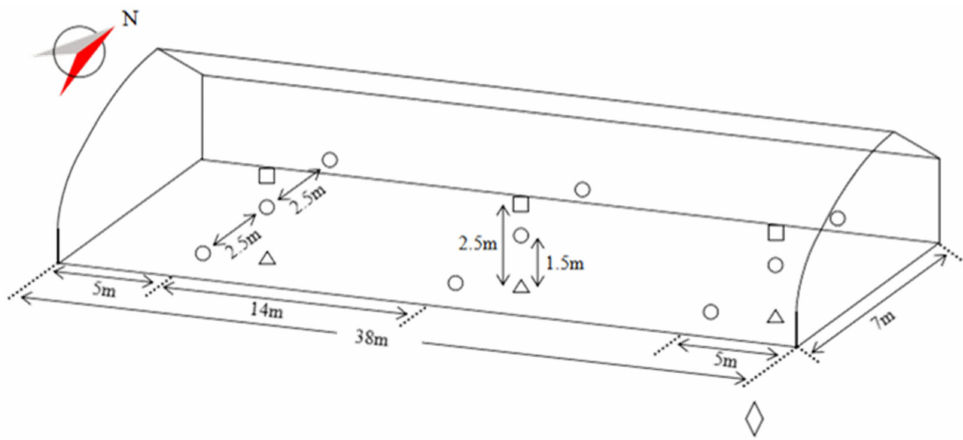
Figure 1. The schematic diagram of the experiment sensors equipment installation. represents the 1.5 m high environmental monitoring nodes, represents the 2.5 m high wireless temperature and humidity sensors, represents the soil temperature and water potential sensors in the soil layer of 0.15–0.2 m, ♦ represents the weather station; N means north.